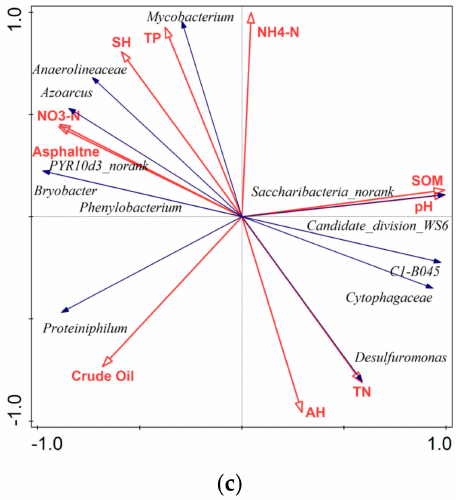
Figure 5. The RDA of bacteria and environmental factors in P2C1 ( a ), P2C2 ( b ), and P2C3 ( c ) treatments (SH and AH are the abbreviations for saturated and aromatic hydrocarbon,